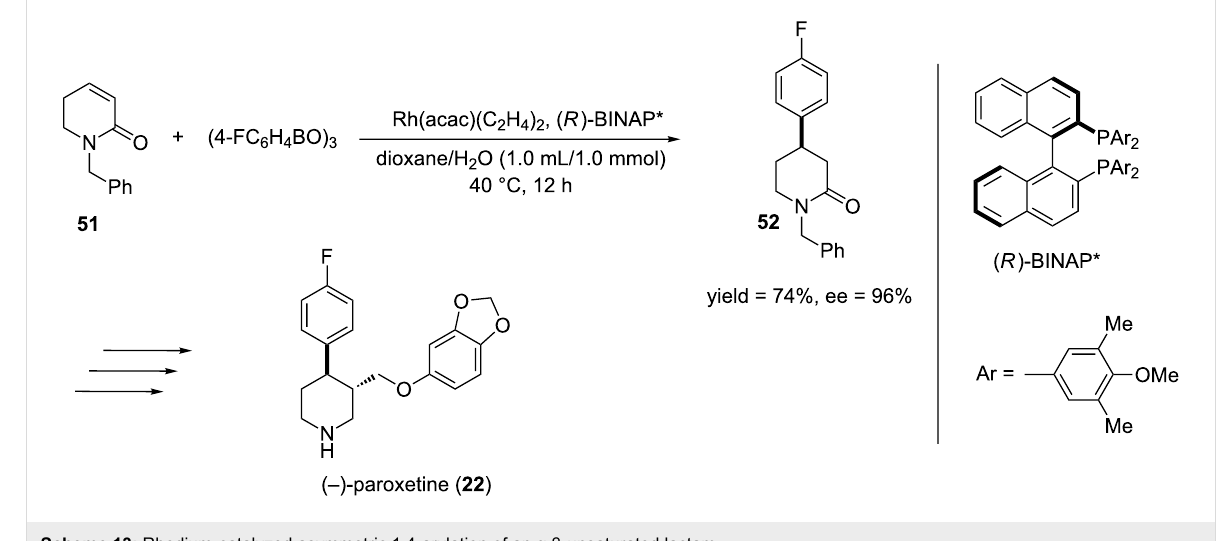
Scheme 13: Rhodium-catalyzed asymmetric 1,4-arylation of an α , β -unsaturated lactam.